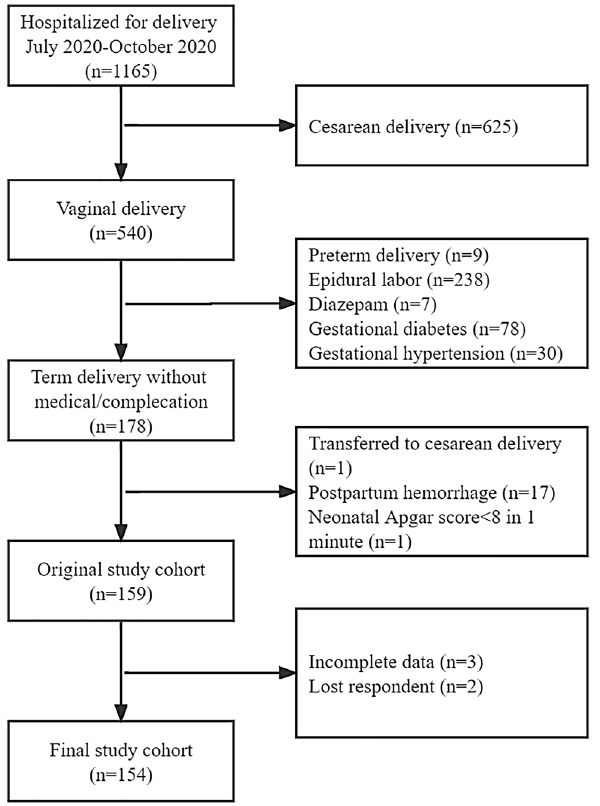
Figure 1. Recruiting fow diagram. Notes : * P < 0.05, ** P < 0.01, *** P < 0.001; if the letters marked at the top of the bar chart were different, there was a statistically significant difference between the two groups. Otherwise, there was no